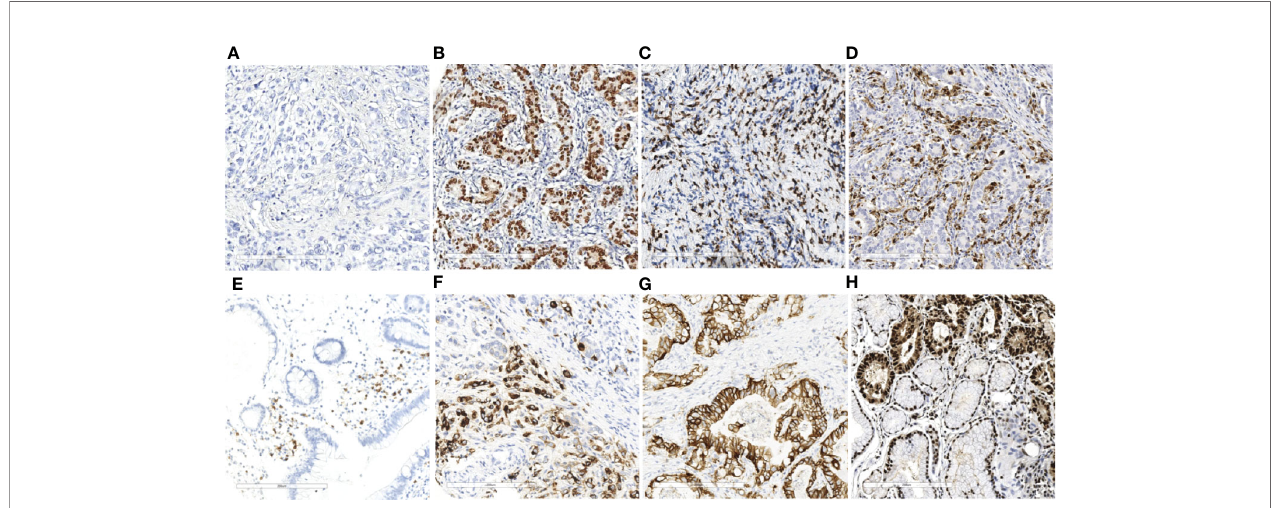
FIGURE 1 | EBER ISH and immunohistochemistry results of immune markers in gastric cancer (×20). EBER ISH-negative (A) and EBER ISH-positive (B) cases. Representative images of CD3 + T lymphocytes (C) CD68 + macrophage (D) CD20 + B lymphocyte cells (E) and CD57 + NK cells (F) and expression levels of HER2 (G) and PCNA (H) in gastric cancer